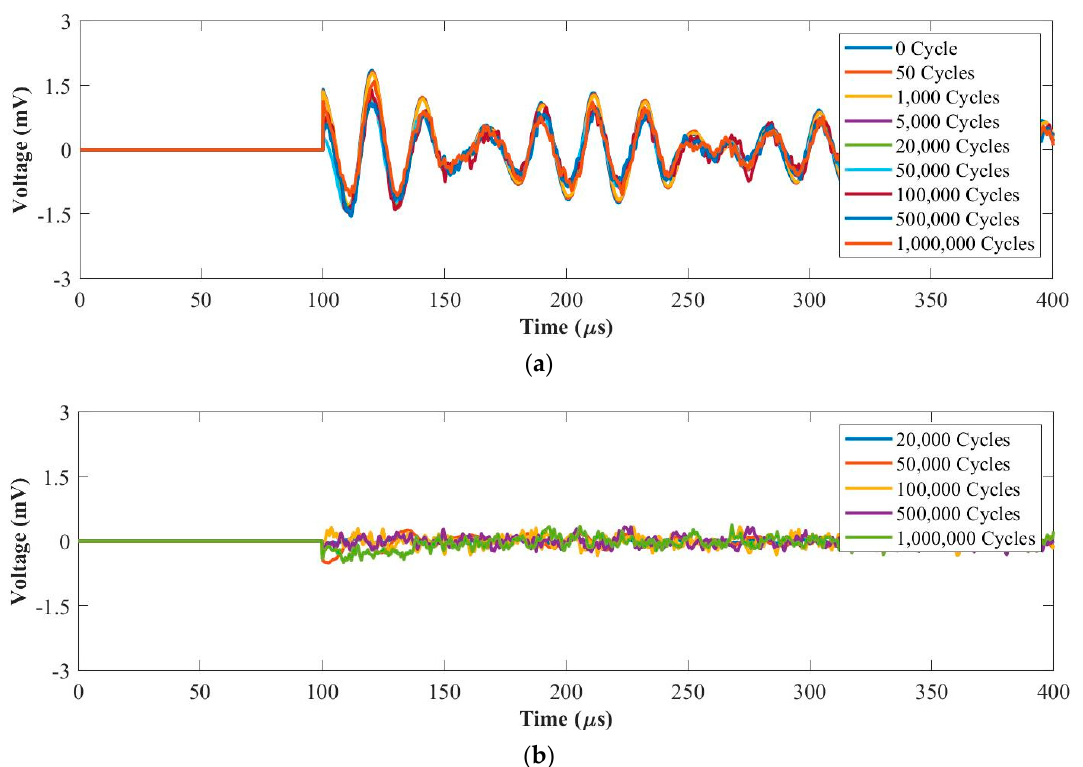
Figure 7. UGW comparisons within 1 million cycles for ( a ) original signals and ( b ) residual signals under the force range of 0.5~5 kN at 50 kHz.